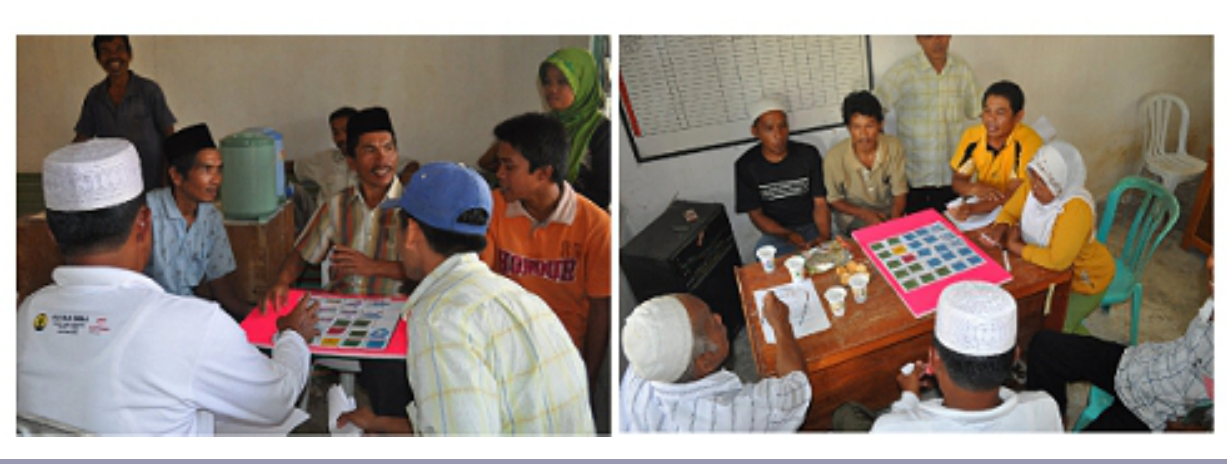
Fig. 7. Village groups discussing their decisions with their game boards. (Photos by